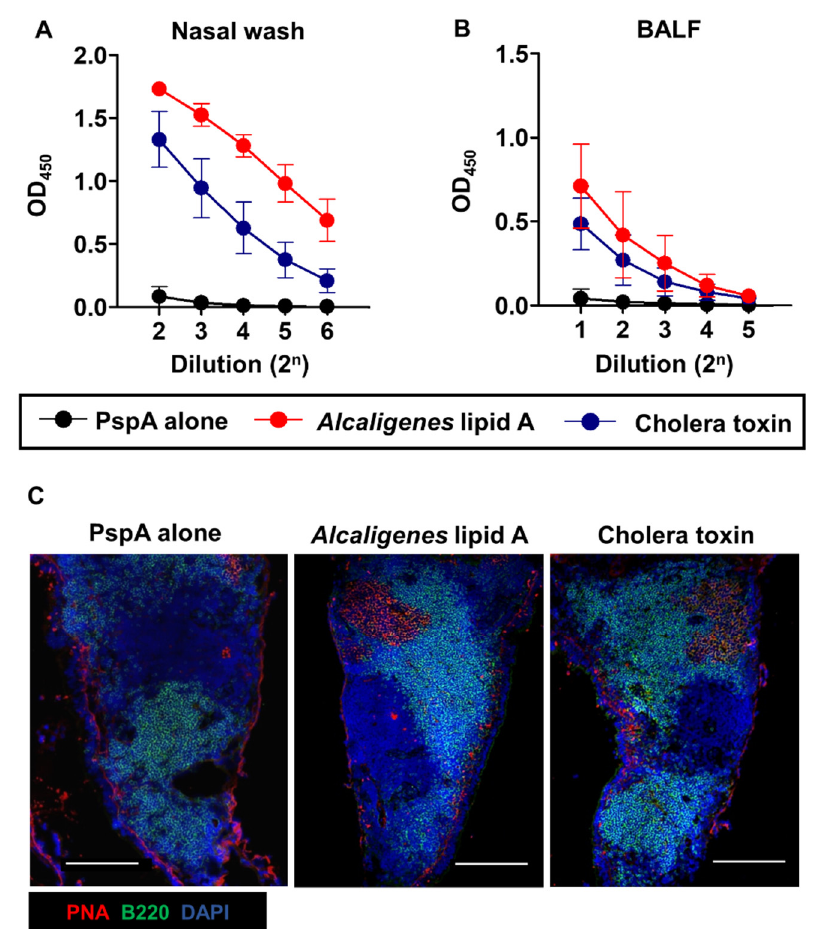
Figure 1. Nasal immunization with pneumococcal surface protein A (PspA), together with Alcaligenes lipid A enhances PspA-specific nasal immune responses through the induction of germinal center formation in the nasopharynx-associated lymphoid tissue (NALT). Mice were nasally immunized with PspA with or without Alcaligenes lipid A or cholera toxin three times at one-week intervals. One week after the final immunization, nasal wash ( A ) and bronchoalveolar lavage fluid (BALF) ( B ) were collected from immunized mice to measure the levels of PspA-specific IgA by enzyme-linked immunosorbent assay (ELISA). Data are representative of two independent experiments and are expressed as means ± SD ( n = 6 per group). OD, optical density. ( C ) NALT was prepared, stained with the indicated antibodies and reagents, and then observed by using fluorescence microscopy. Images are representative of two independent experiments. Scale bars: 200 µ